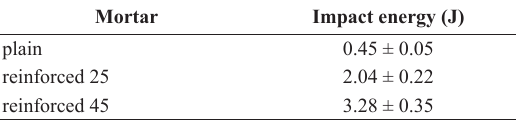
Table 2. Impact energy of the plain and reinforced mortars. Mortar